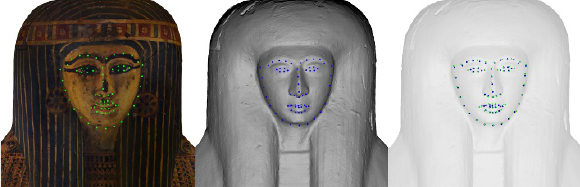
Figure 10. An example of successful detection of facial landmarks. On the right, the points detected on the two orthoimages are compared (© ‘Museo Egizio’,